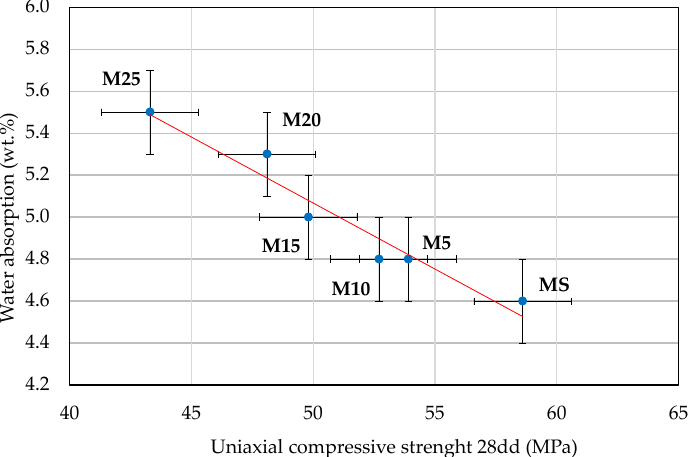
Figure 9. Uniaxial compressive strength vs. water absorption by total immersion referred to weight of the MS, M5, M10, M15, M20, and M25 mortar mixtures at 28 days of